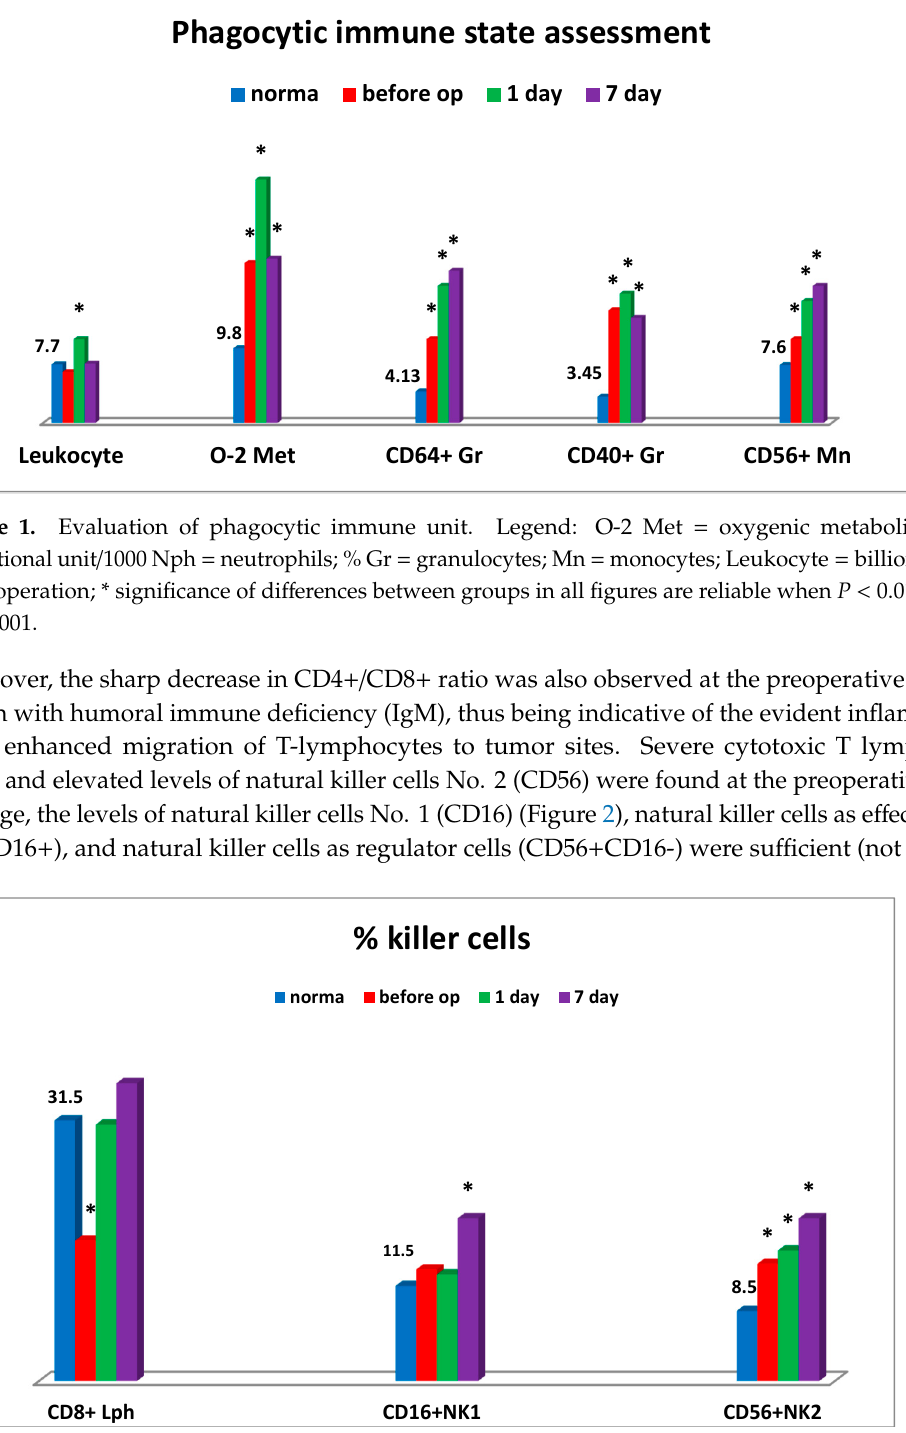
Figure 2. Dynamics of the content of killer cells in patients. Legend: Lph = lymphocytes; NK1 = natural killer cells; NK2 = natural killer cells; * significance of differences; op = operation.